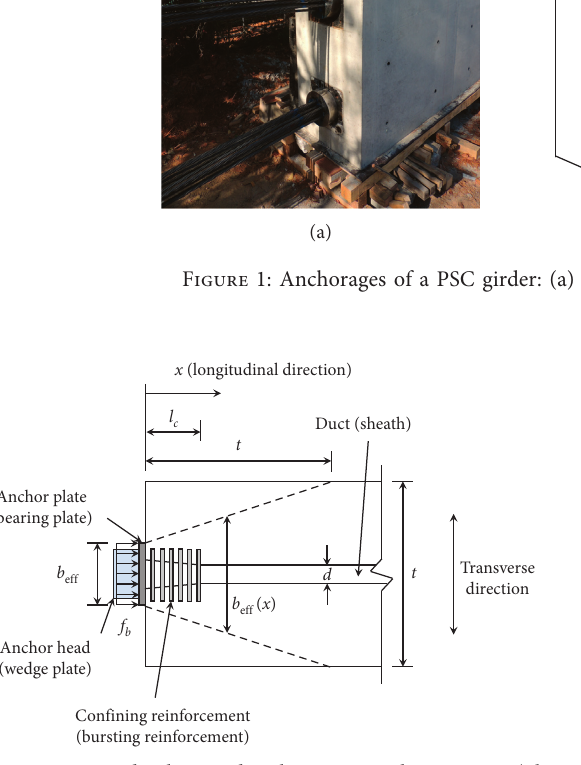
Figure 2: Longitudinal stress distribution in anchorage zone (plan view of Figure 1(b)).